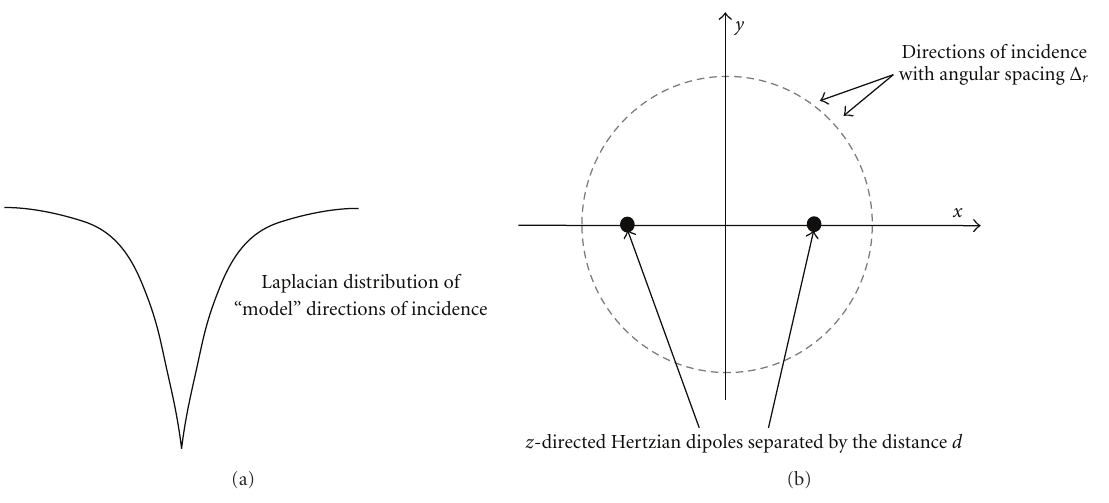
Figure 6: Two z -directed Hertzian dipoles on the x -axis at r 1 = ( − d/ 2,0,0) and r 2 = ( d/ 2,0,0) with surrounding plane-wave directions of propagation and Laplacian distribution. All directions of incidence are in the x - y plane.